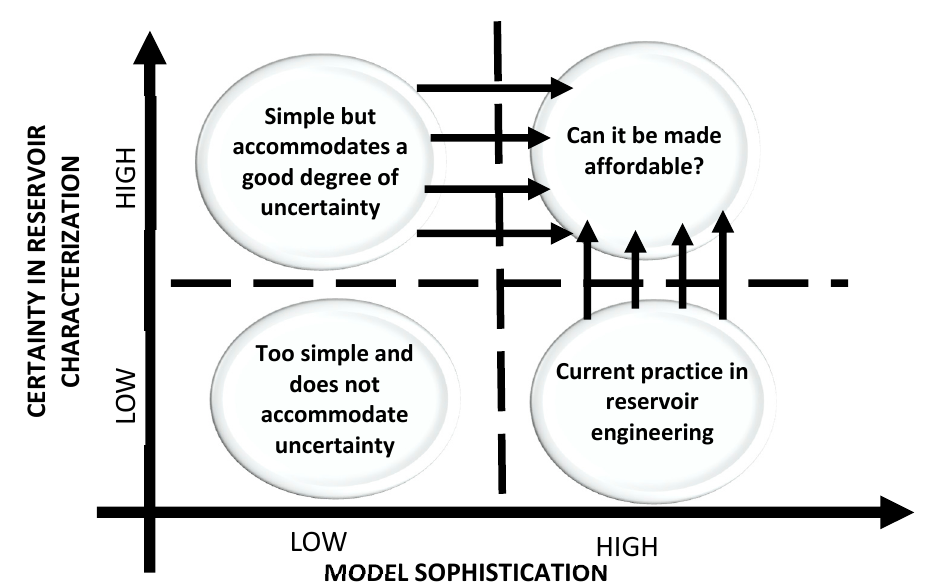
Figure 20. Choices in reservoir model development.